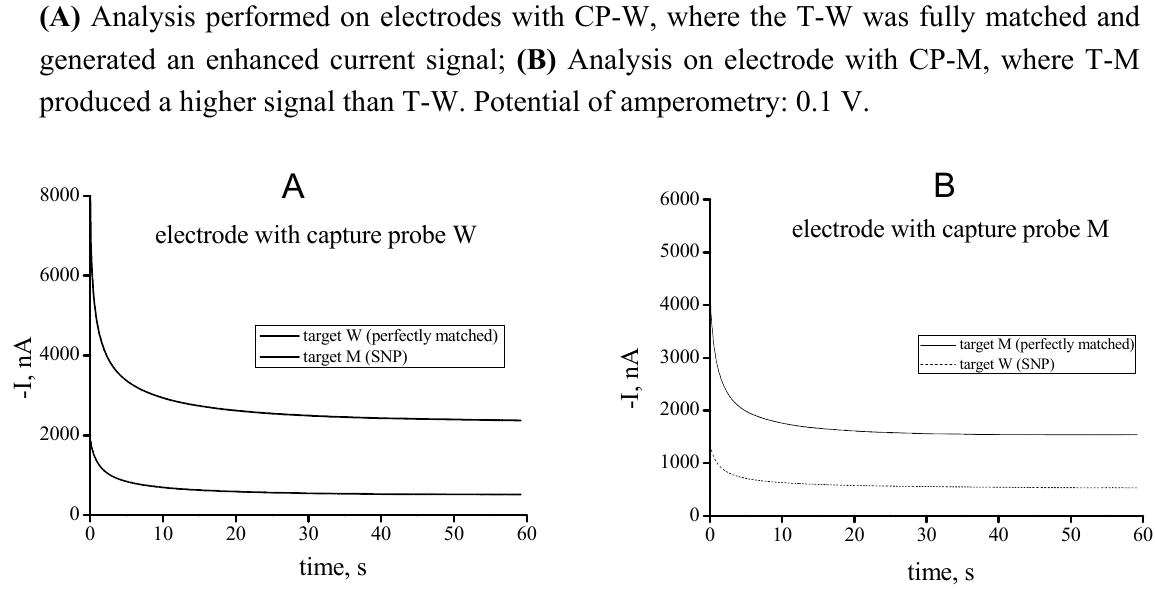
Figure 1. Amperometric curves for the detection of single base mismatched (dashed line) and complemental probe (solid line) in the presence of the complementary target of 5 nM.